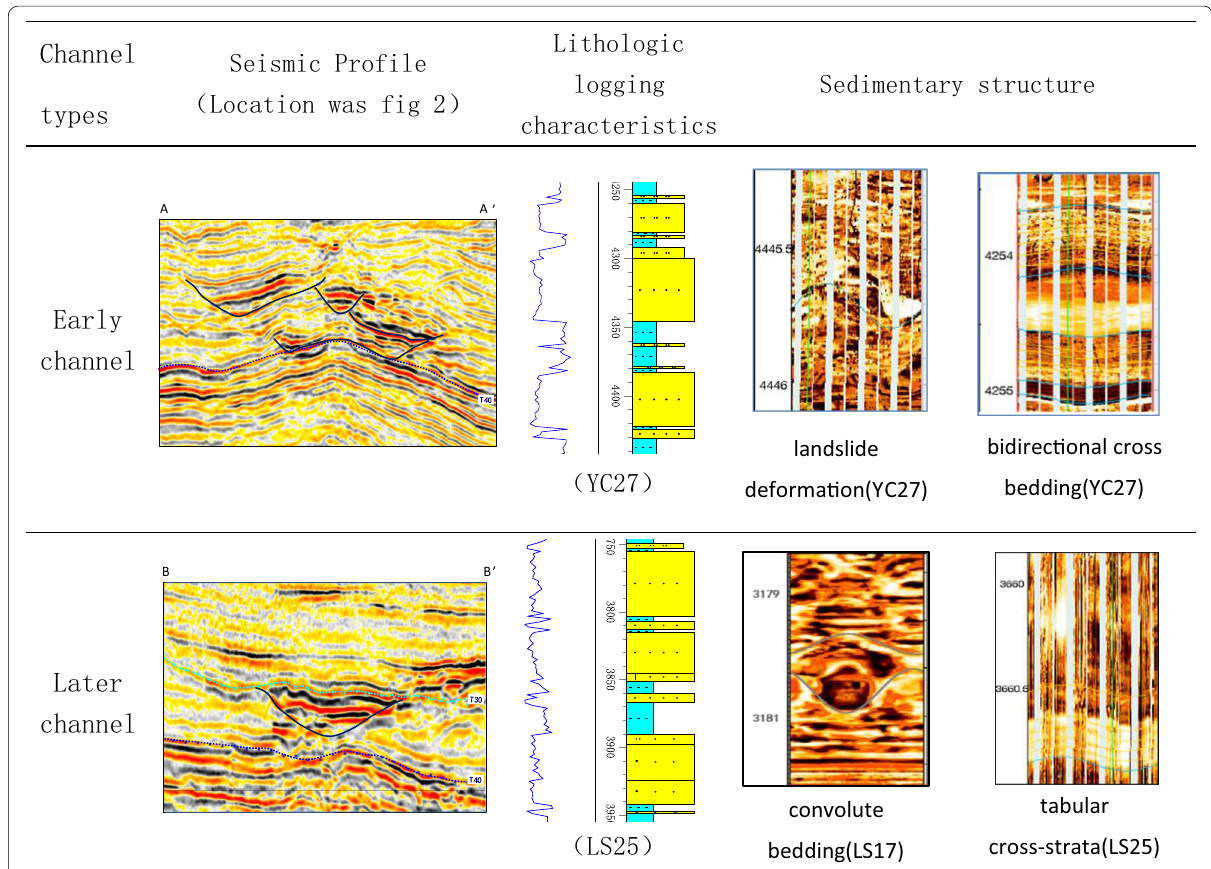
Fig. 3 The sedimentary characteristics of two-stage channels in the Huangliu Formation, Qiongdongnan